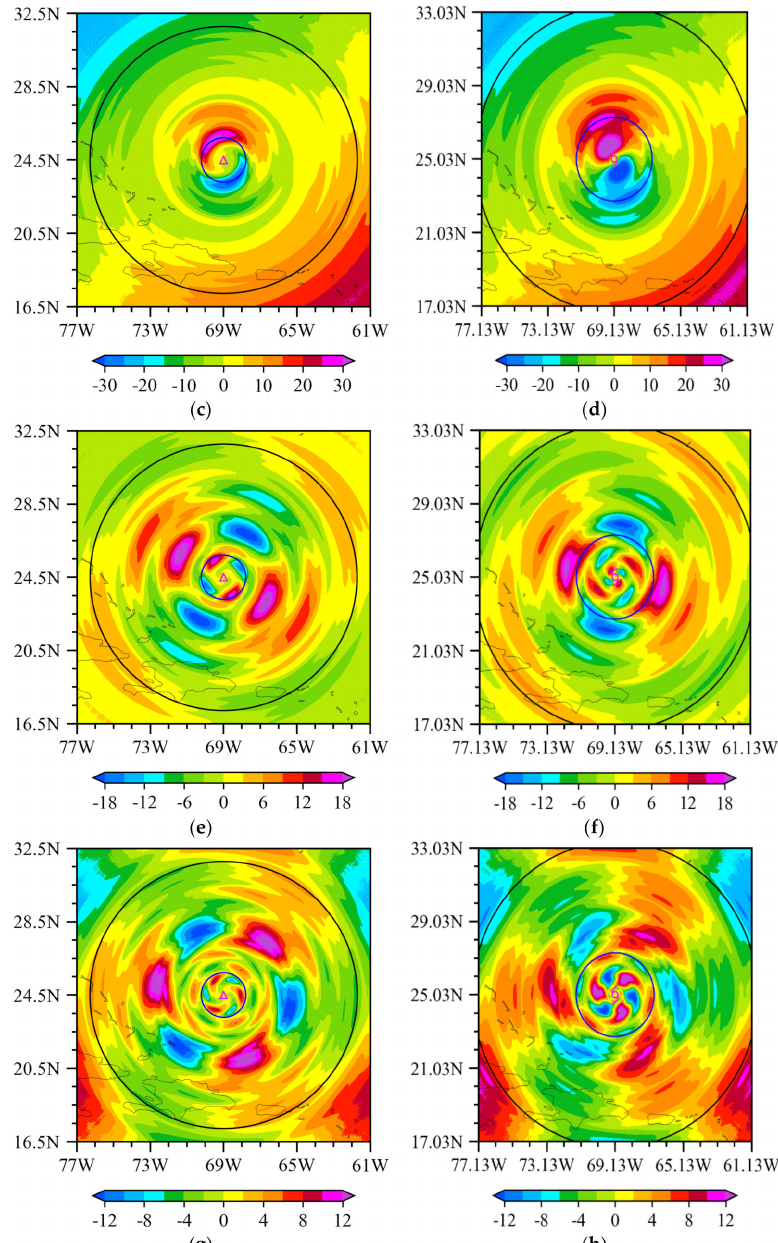
Figure 14. Spatial distributions of ( a – h ) wavenumbers 0–3 components (color shading; unit: K) of ABI channel-13 TB observations around Hurricane Jose centered at the ABI-determined cen- ter (magenta open triangle; left panel) and best track (magenta hurricane symbol; right panel) at 1000 UTC September 11, 2017. The R IR (blue circle) and R OR (black circle) are also indicated. The average value of wavenumber-0 amplitudes and maximum wavenumbers 1,